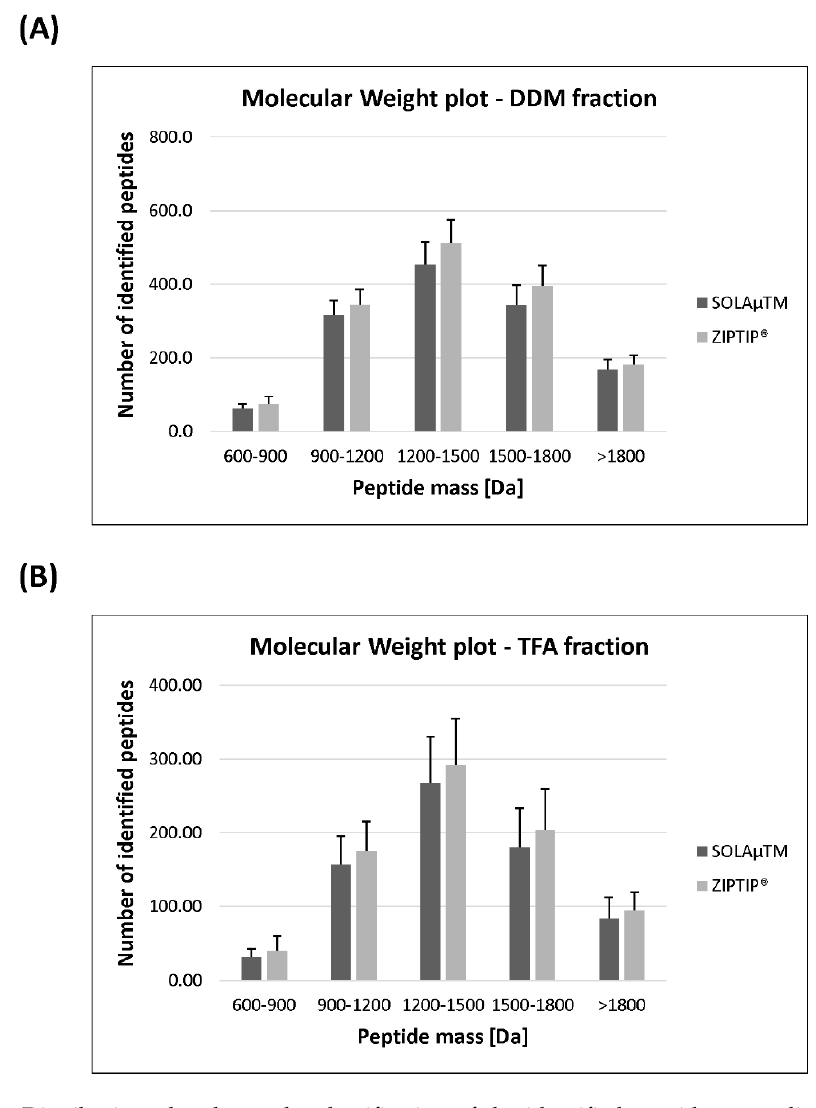
Figure 3. Distribution plot shows the classification of the identified peptides according to their characteristic molecular weight (MW). Peptides were clustered in the molecular mass range of ≥ 1800 Da, <1800 to ≥ 1500 Da, <1500 to ≥ 1200 Da, <1200 to ≥ 900 Da and <900 to ≥ 600 Da. ( A ) Bar plot shows the MW distribution of the identified peptides in the DDM fraction after enrichment with to different SPE-based purification methods (SOLA µ TM and ZIPTIP ® ). ( B ) Distribution profiles of the MW of the identified peptides in the TFA fraction after enrichment with to different purification methods.